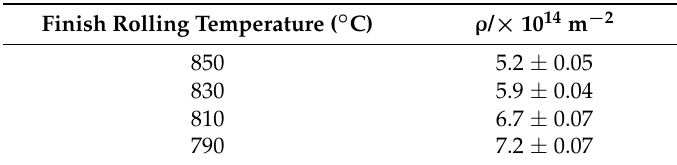
Table 5. The density of dislocations of samples varied with a finish rolling temperature from 850 ◦ C to 790 ◦